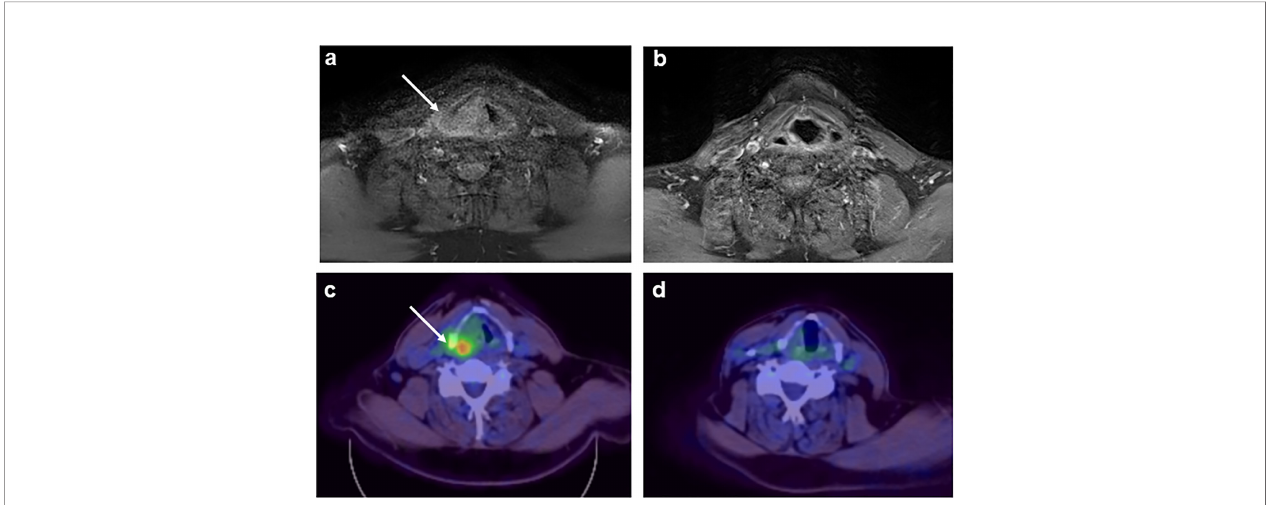
FIGURE 1 | MRI (A, B) and 18-FDG-PET (C, D) of the neck displaying a laryngeal tumor mass at initial diagnosis [ (A, C) ; arrow] and complete remission of the tumor formation after induction + consolidation I (B, D)